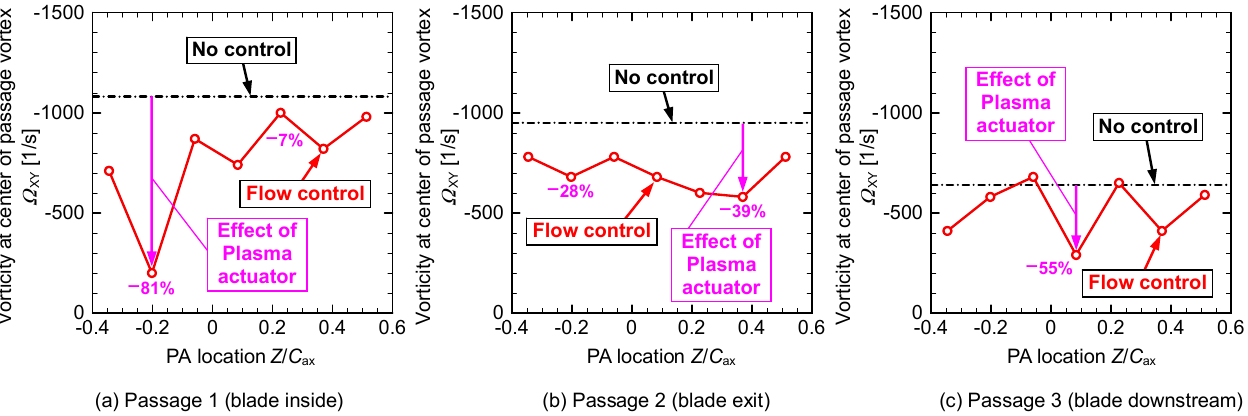
Figure 25. Effect of the plasma actuator location on vorticity at the center of the passage vortex (Re out = 3.7 × 10 4 ).